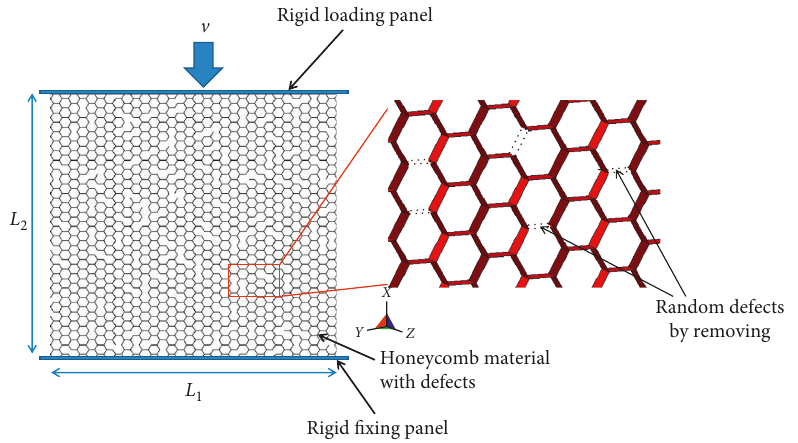
Figure 1: Finite element model of honeycombs with random defects. Table 1: Material parameters of aluminum metal.